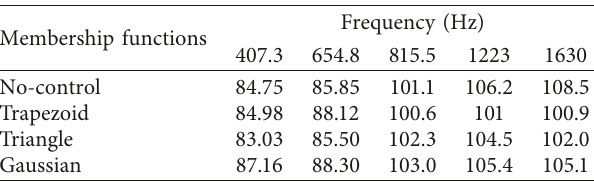
Figure 11: Frequency domain vibration active control of gear system based on different defuzzification methods. Table 3: The amplitudes of the system at the main frequencies based on different membership